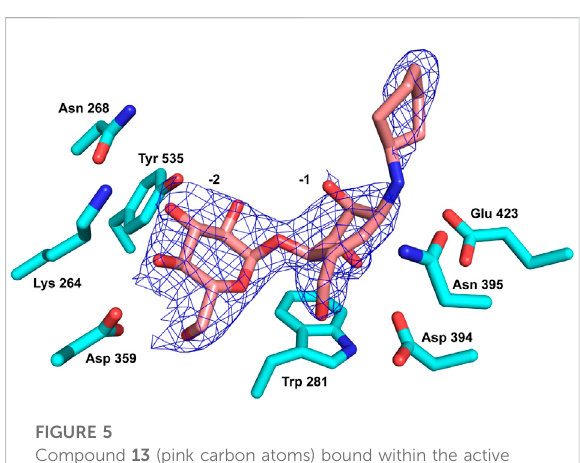
FIGURE 5 Compound 13 (pink carbon atoms) bound within the active site of Sco GlgEI-V279S (cyan carbon atoms). The 2Fo-Fc map is contoured at 1.5 σ .